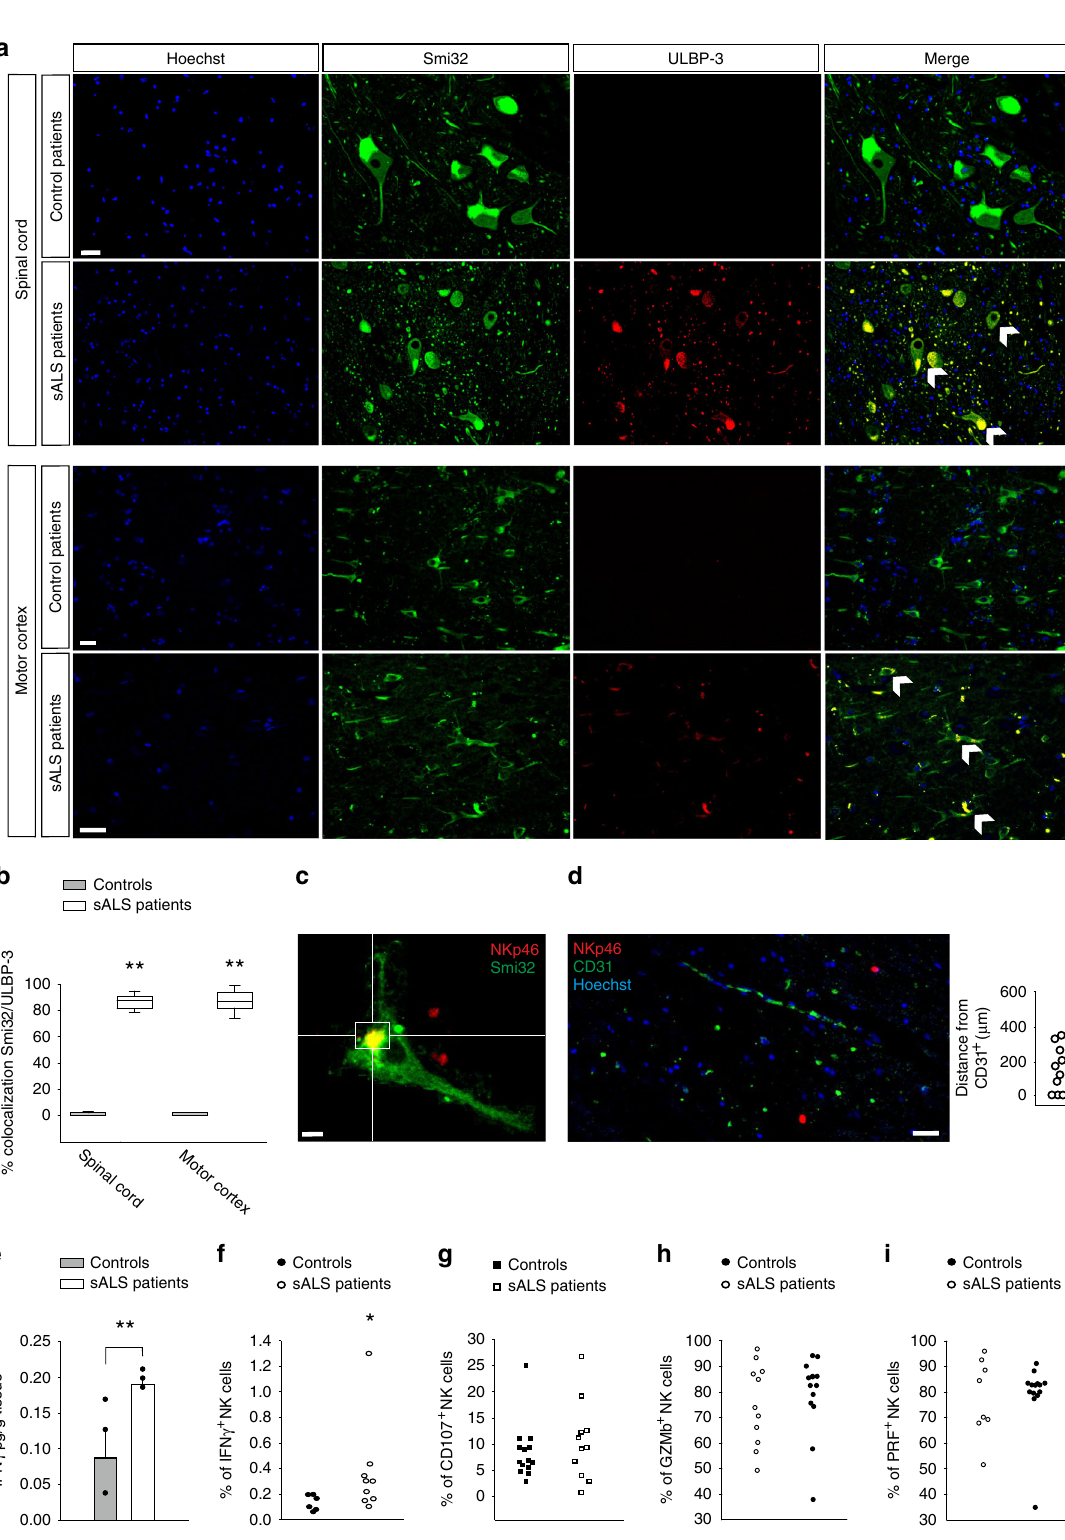
calculated to give an indication of branching complexity. The areas of the soma and scanning domain were measured for each cell. 3D reconstruction of NK cells was achieved by confocal microscopy analysis with a FV1200 (Olympus) Laser Scanning System, at ×60 magni fi cation. NK cells were identi fi ed with an Alexa fl uor 594 conjugated NKp46 antibody. Acquisition fi les were then processed with ImageJ software for two-dimensional analysis. Three-dimensional reconstructions were generated with Imaris software (Bitplane, Zurich, Switzerland).